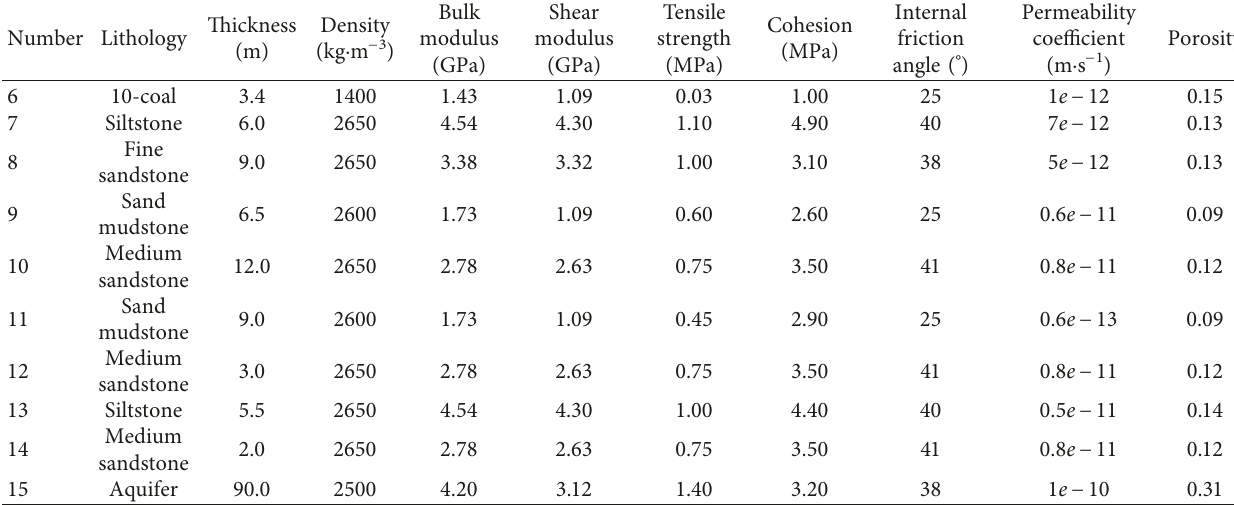
Table 2: Physical and mechanical parameters of the 1066 inclined coal seam workface floor strata after changing. Thickness Number Lithology